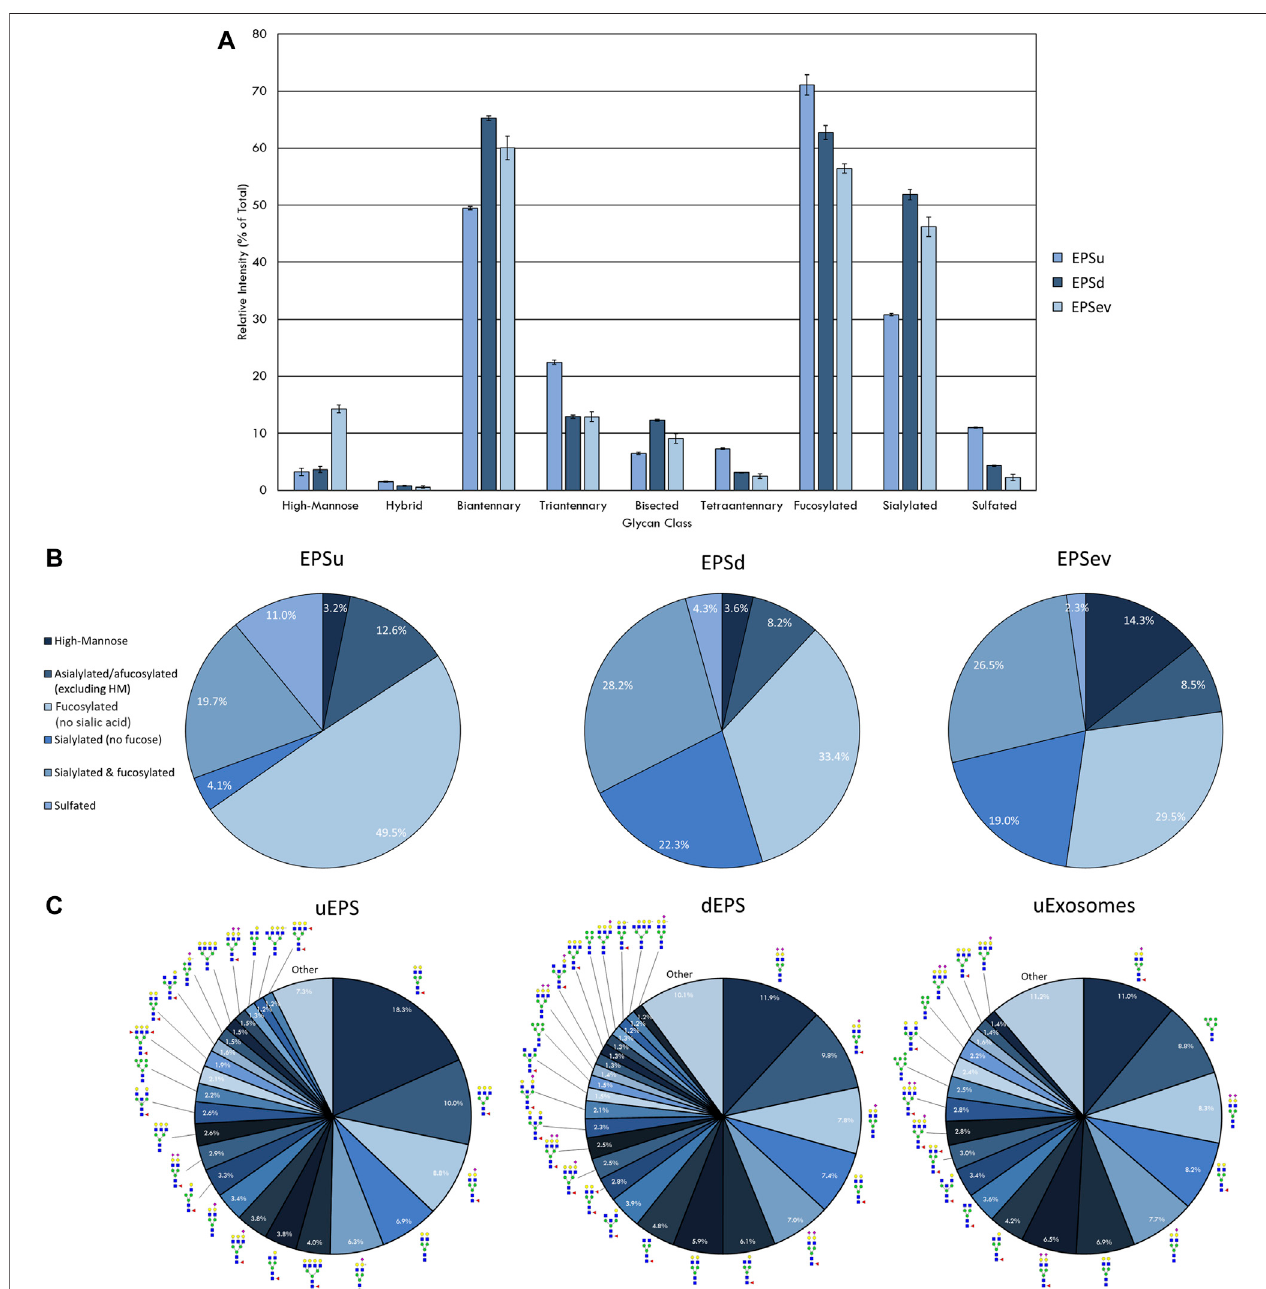
deviation. (B) Distributions of representative samples ’ N-glycans assigned into groups based on composition. (C) Distribution of total N-glycan intensity by individual N-glycan, with N-glycans comprising at least 1% of the total intensity displayed and annotated. The N-glycan compositions are represented by blue squares for N -acetylglucosamine, green circles for mannose, yellow circles for galactose, purple diamonds for sialic acid, red triangles for fucose, and an “ S ” for